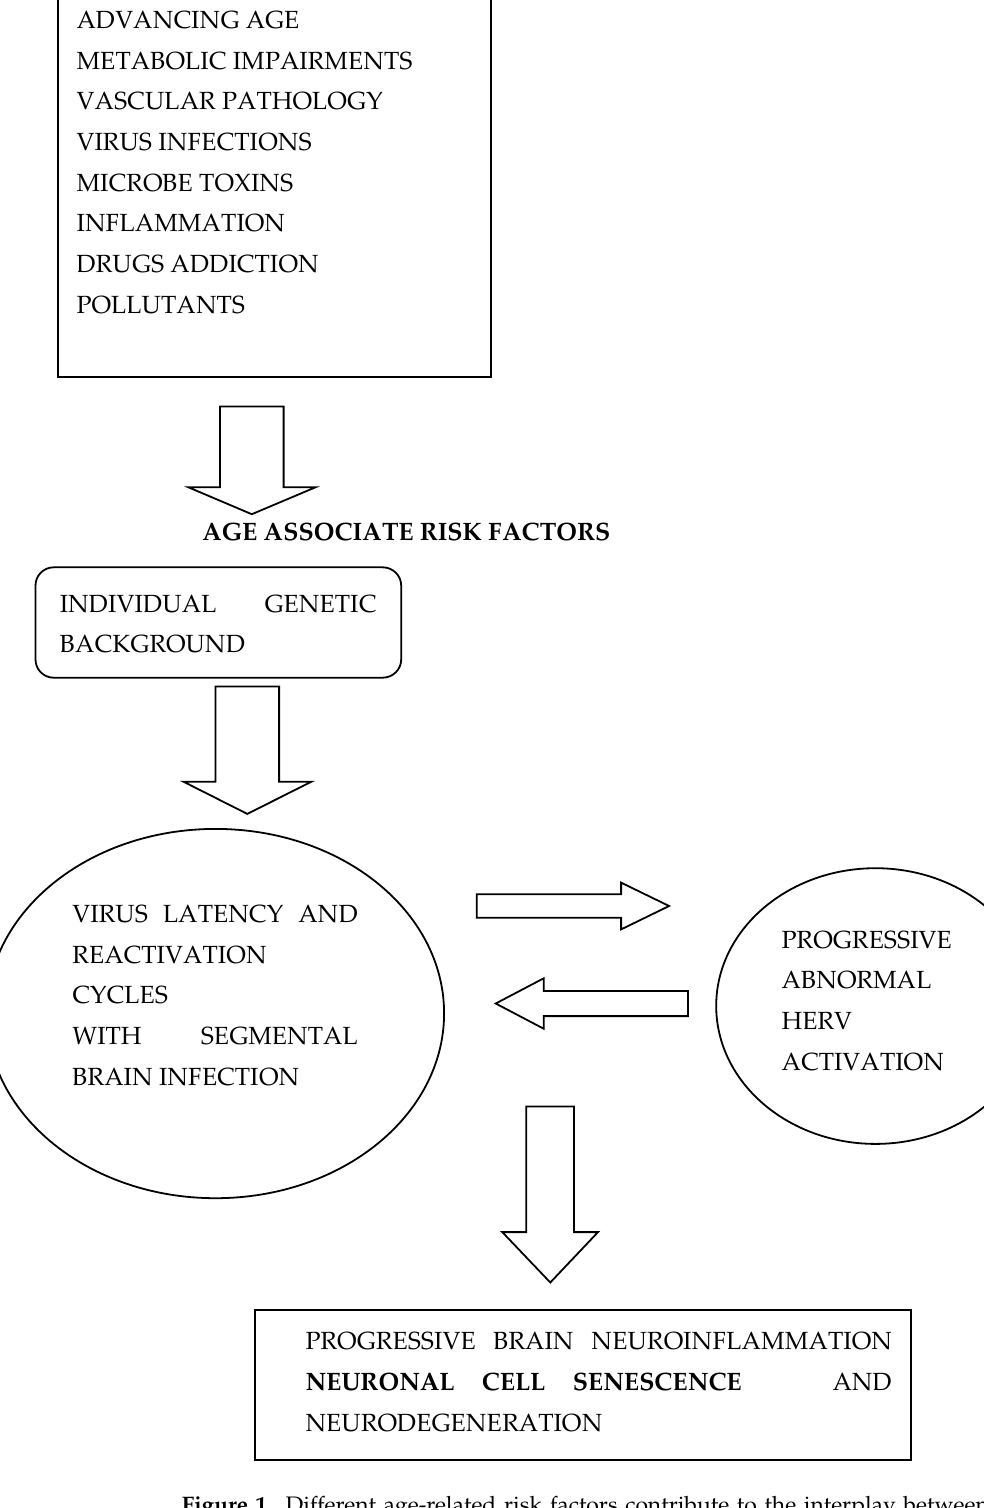
Figure 1. Different age-related risk factors contribute to the interplay between exogenous virus infections and HERV abnormal activation leading to neuronal cell senescence and further neurode- generative processes and AD.